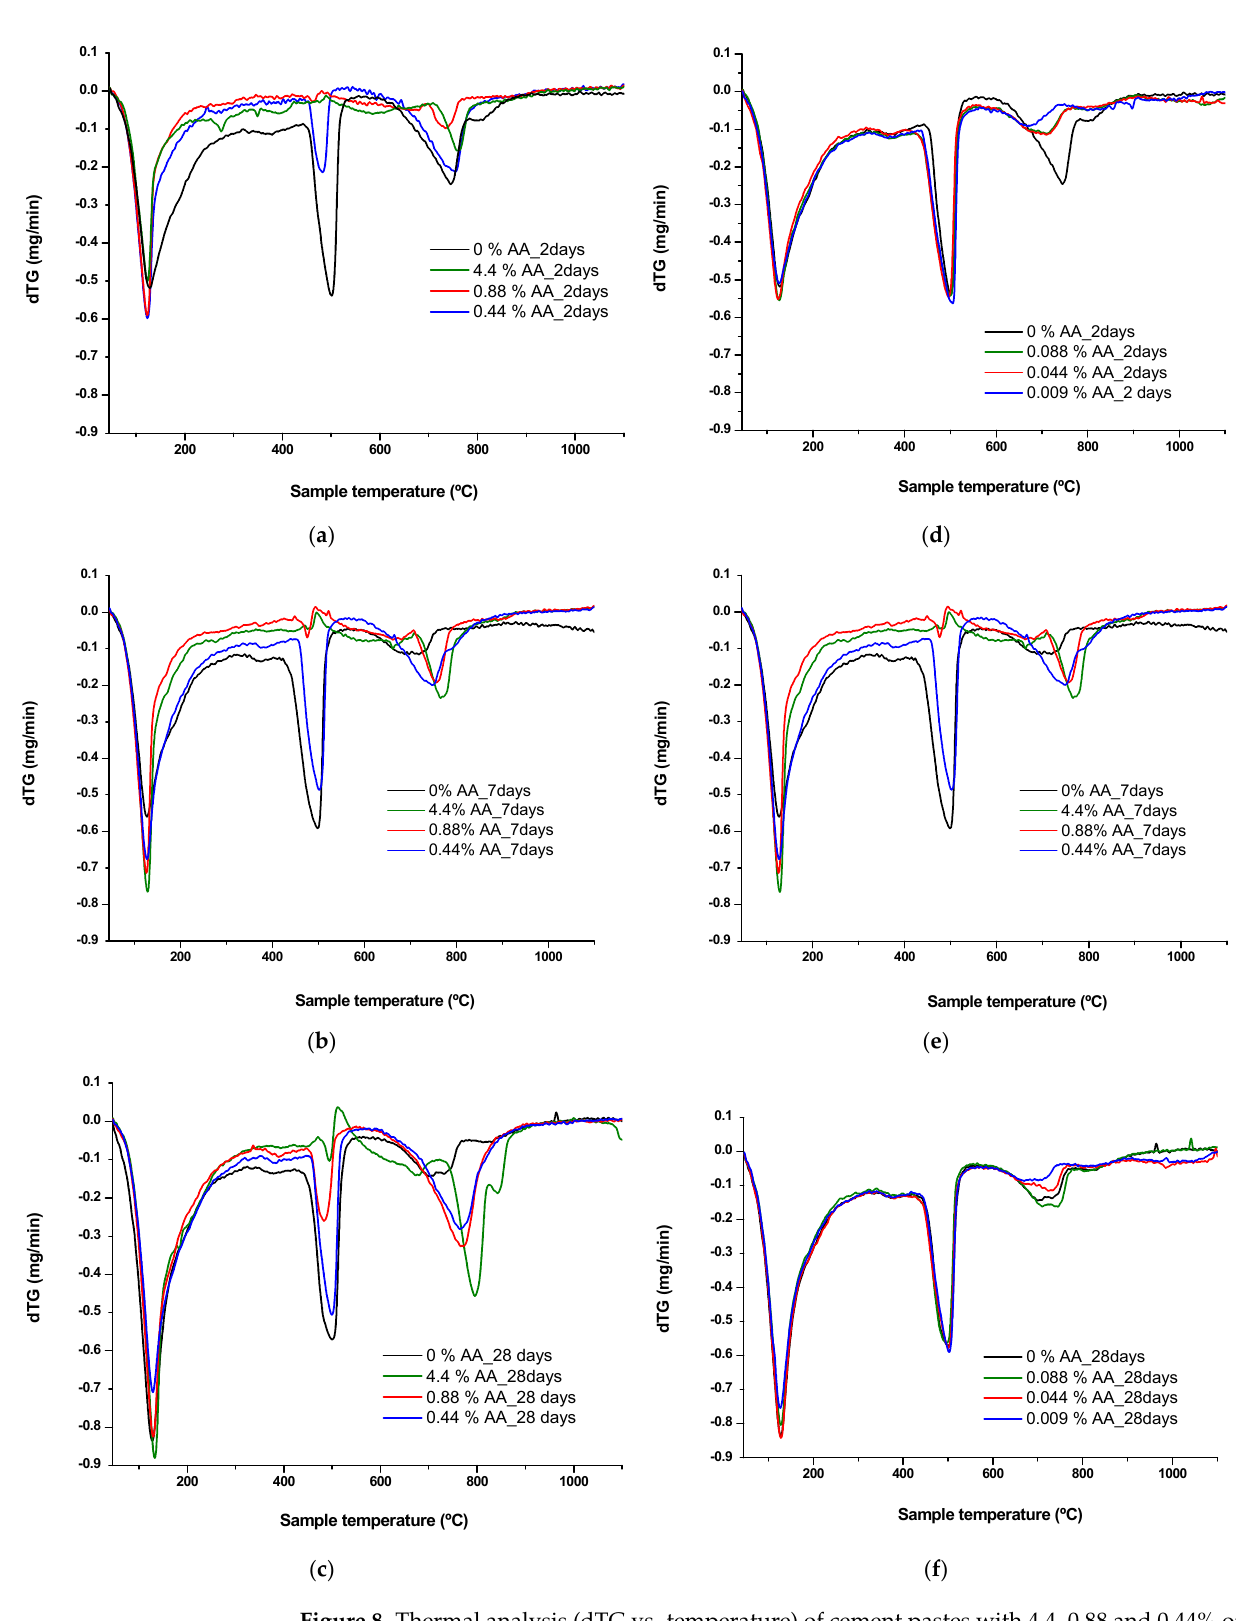
Figure 8. Thermal analysis (dTG vs. temperature) of cement pastes with 4.4, 0.88 and 0.44% of AA ( a – c ); 0.088, 0.044, 0.009% of AA ( d – f ); after 2, 7 and 28